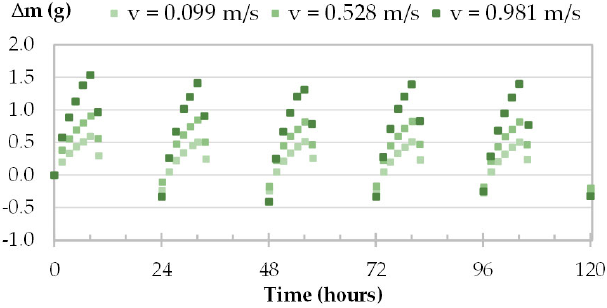
Figure 10. Moisture uptake and release kinetics for one specimen of TH (TH-c-7) in tests 1-2-3.